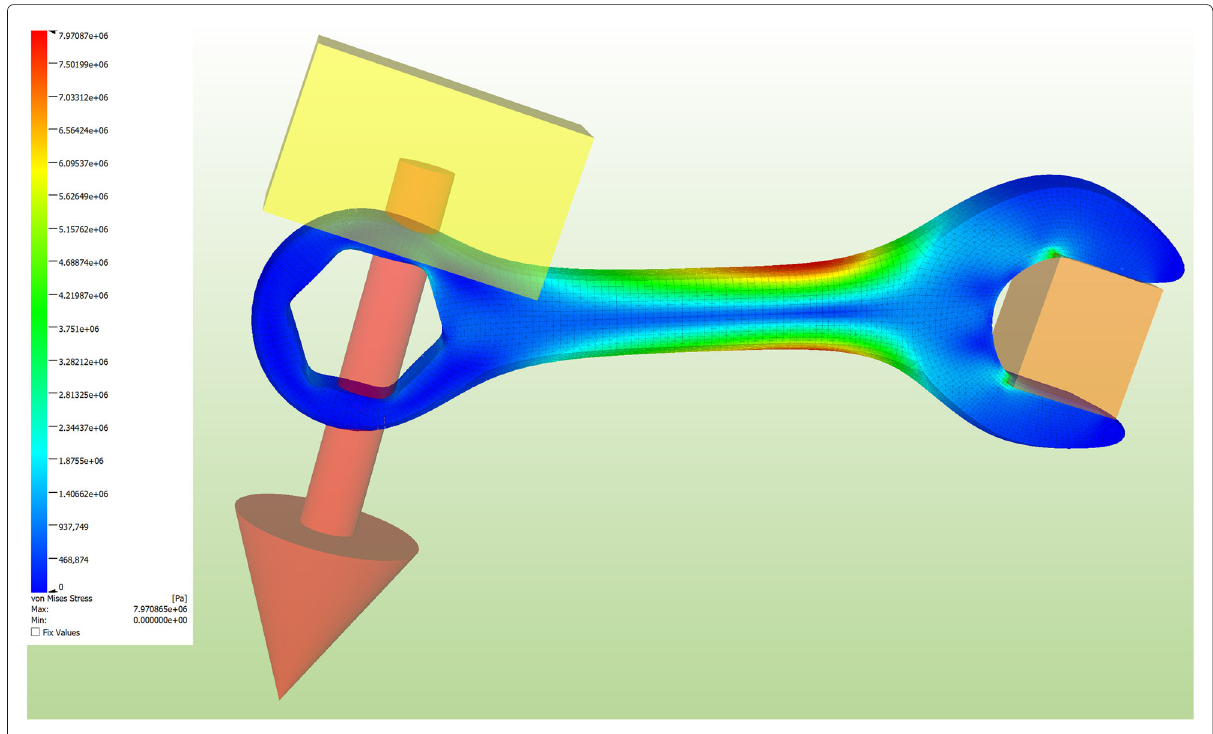
Fig. 18 Simulation scenario